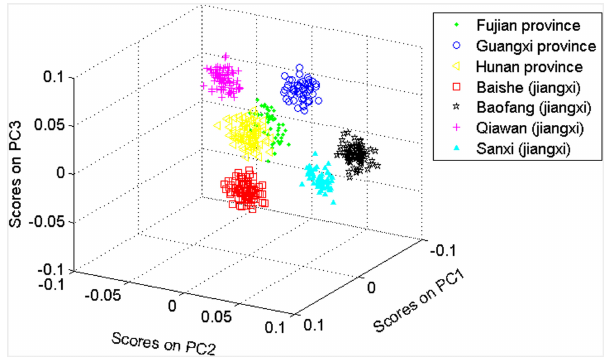
Fig. 4. Three-dimensional scores plot from PCA of NIR spectra after optimal pretreatment and CSMVPCA variable selection for calibration